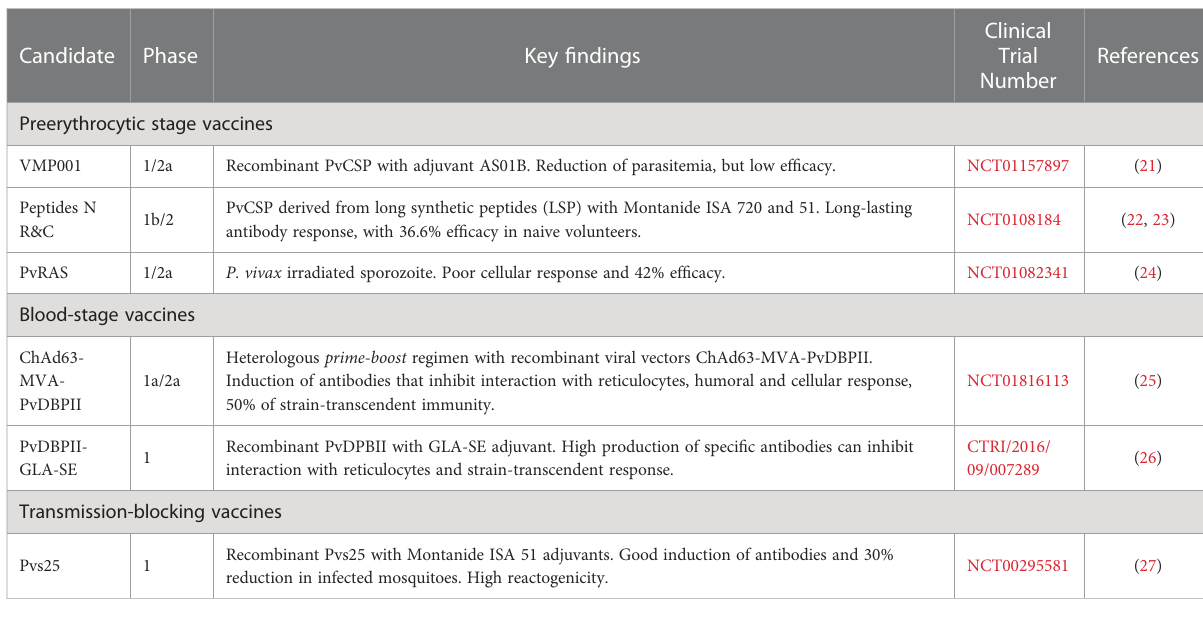
TABLE 1 Plasmodium vivax vaccines in clinical